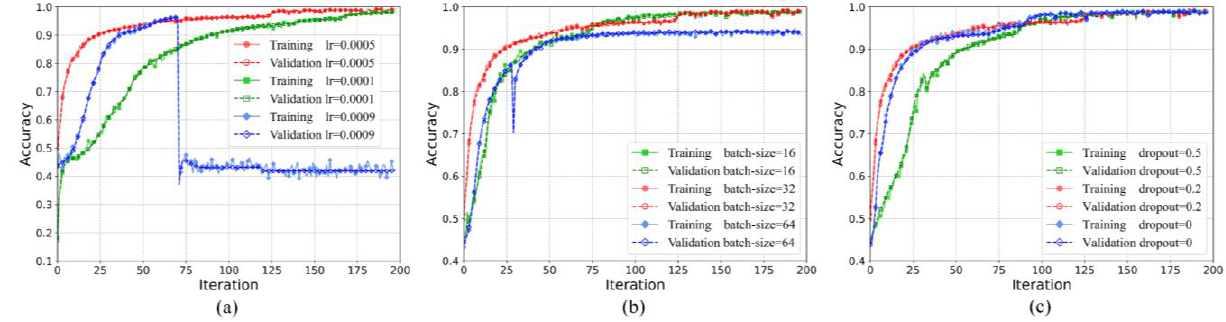
Figure 9. Convergence history (sampled every 200 epochs) under different hyperparameters of the ( a ) learning rate, ( b ) batch-size, ( c ) random deactivation rate (dropout).